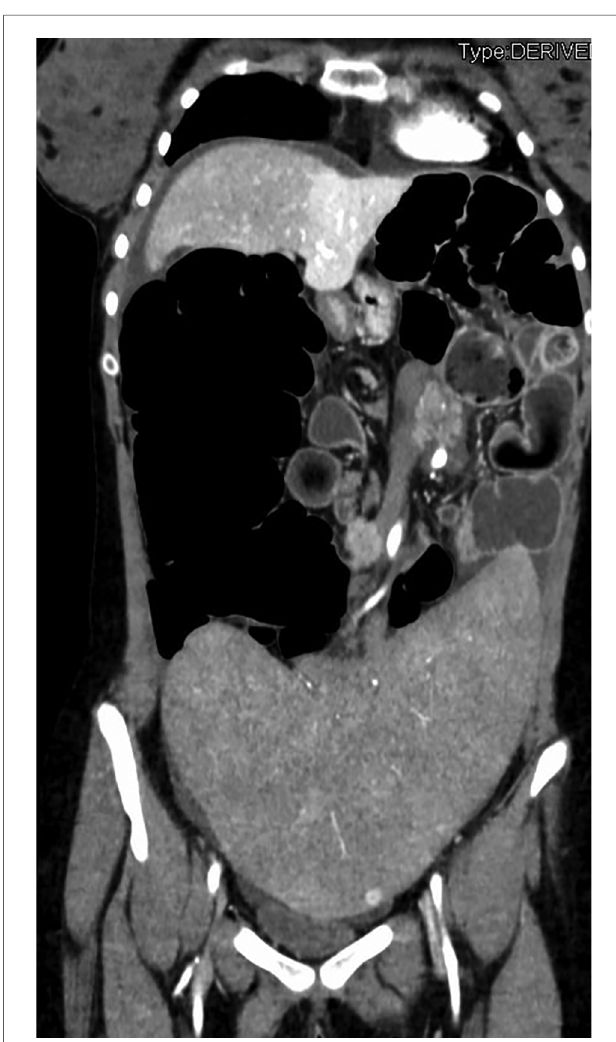
FIGURE 2 Coronal section of patient's CT scan upon admittance, showing enlarged spleen located in the pelvis with torsion of splenic vessels and distended right colon.